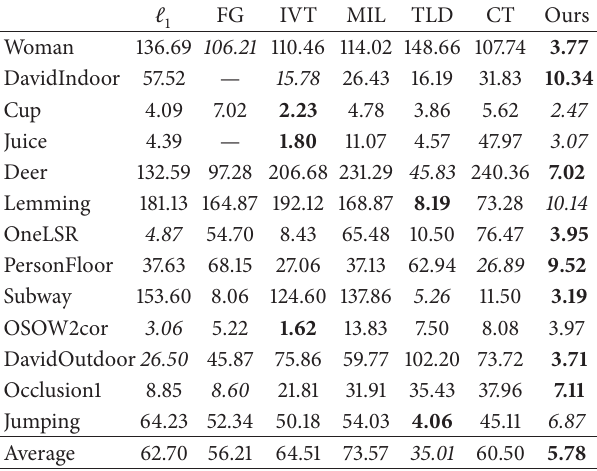
Figure 7: The process of updating. The object is located by LFBs in (a) without occlusion. When occlusion occurs, yet each LFB is valid, the object can be tracked by LFBs exactly, as shown in (b). If occlusion happens and certain LFB is invalid, then it will be replaced and target still can be successfully located, as shown in (c), (d), (e), and (f). Table 2: Center location errors (in pixels). The best result is shown in bold and the second best in italic